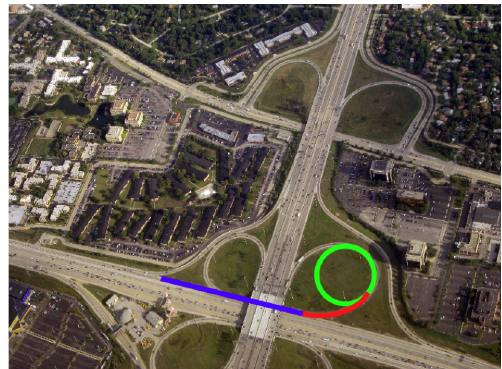
Figure 3. Rotation curve. The transition between the straight part (blue) and circular part (green) is a spiral curve (red). Picture is taken from https://cifrasyteclas.com/clotoide-la-curva-que-vela-por-tu-seguridad-en-carreteras-y-ferrocarriles/.